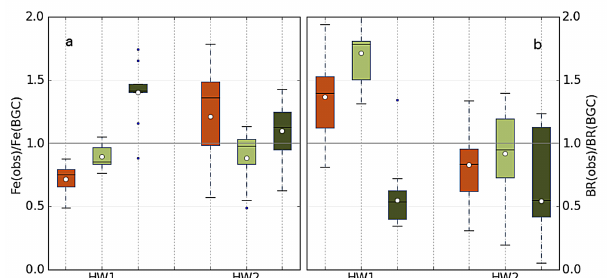
Figure A1. Left panel: boxplot of the ratio of observed latent heat (Fe(obs)) to the BIOS2 climatology of the latent heat flux (Fe(BGC)) during the first and second period of the heat wave (HW1, HW2). Right panel: same as left but for the Bowen ratio. Colours as in Fig. 1.